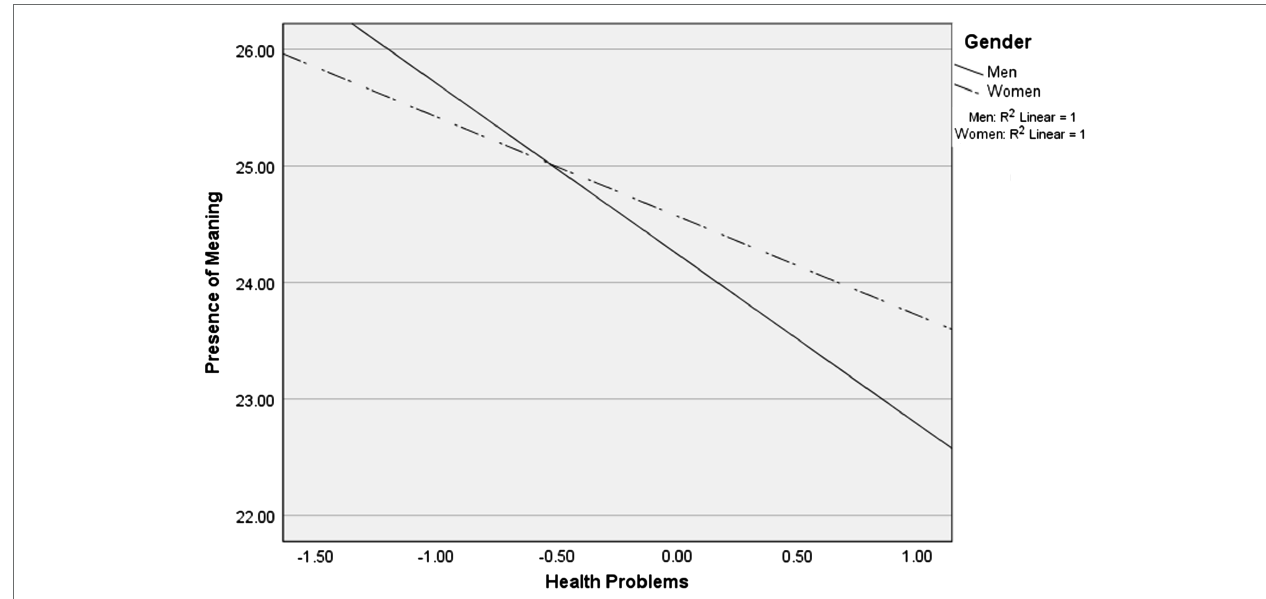
FIGURE 1 | Gender differences in the association between health problems and the presence of